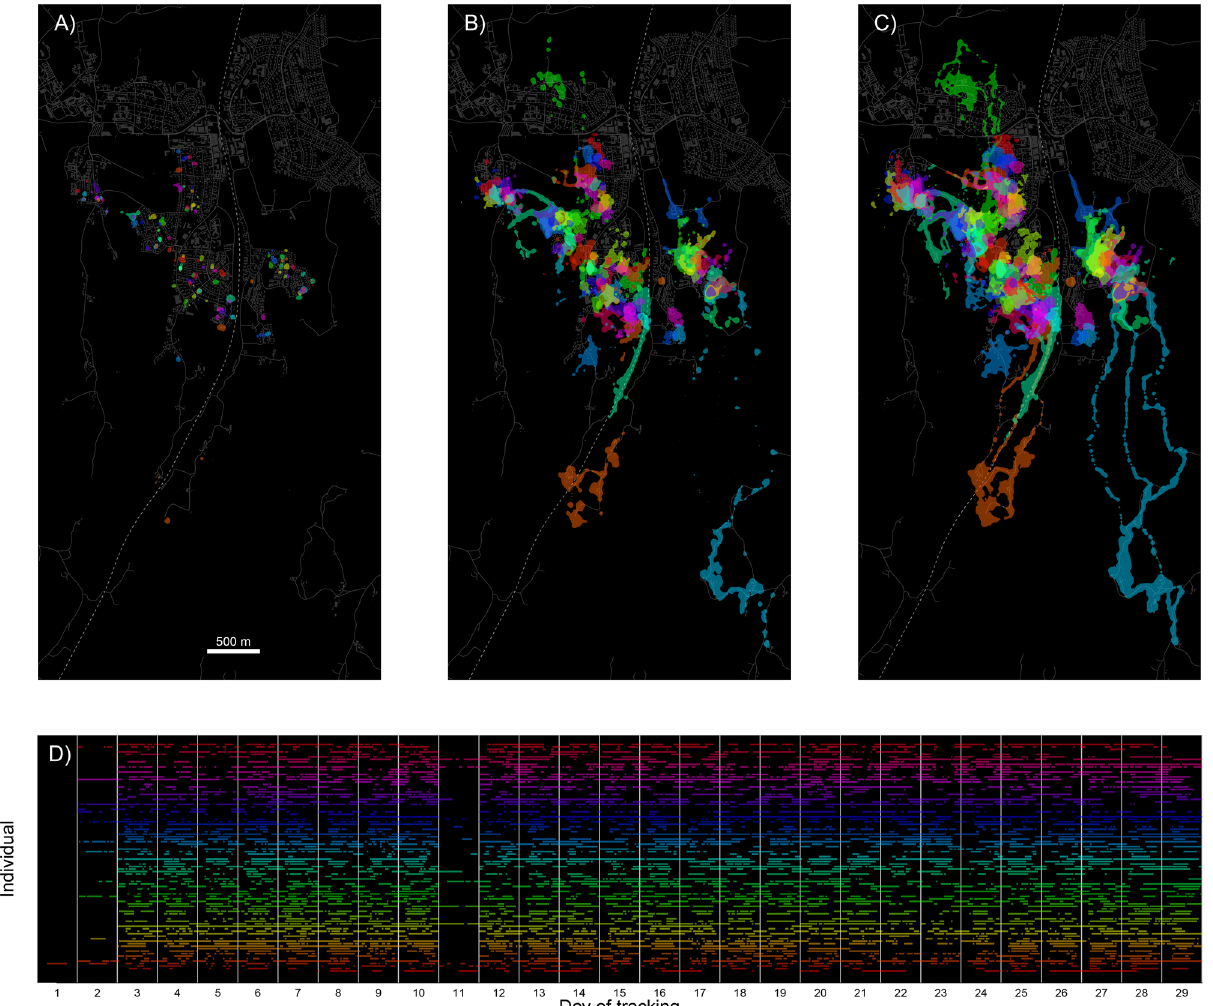
Figure 2. Individual home ranges and temporal tracking coverage for 92 pet cats (color-coded) that were GPS- tracked during May 2021 in a residential area in southern Norway. Shown are 50% ( A ), 95% ( B ), and 99% ( C ) home ranges, based on corresponding vertices of Brownian bridge movement models. Cats spent the majority of their outdoor time in close proximity to their owner’s home, evident in the small core areas (50% home range) compared with the 95% and 99% home range polygons. Grey lines and polygons in the background indicate roads and buildings, respectively. A fenced railroad (dashed line) transects the study area. Panel ( D ) shows the temporal coverage of outdoor GPS tracking data of each cat (rows). A pronounced gap in GPS tracking on day 11 coincides with temporary retrieval of GPS units to download initial data and check for technical problems before continuing tracking. The figure was created using R 17